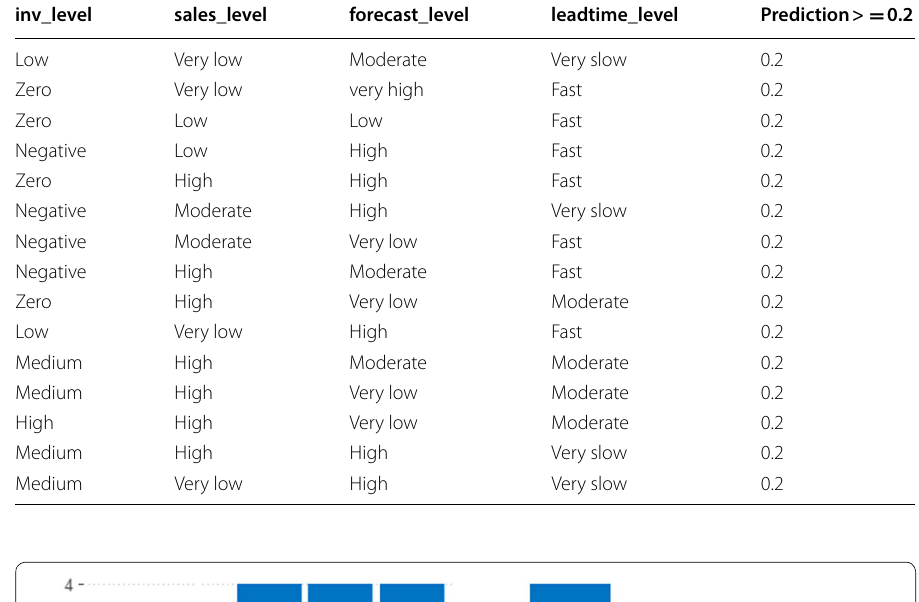
Table 7 Backorder cases where p